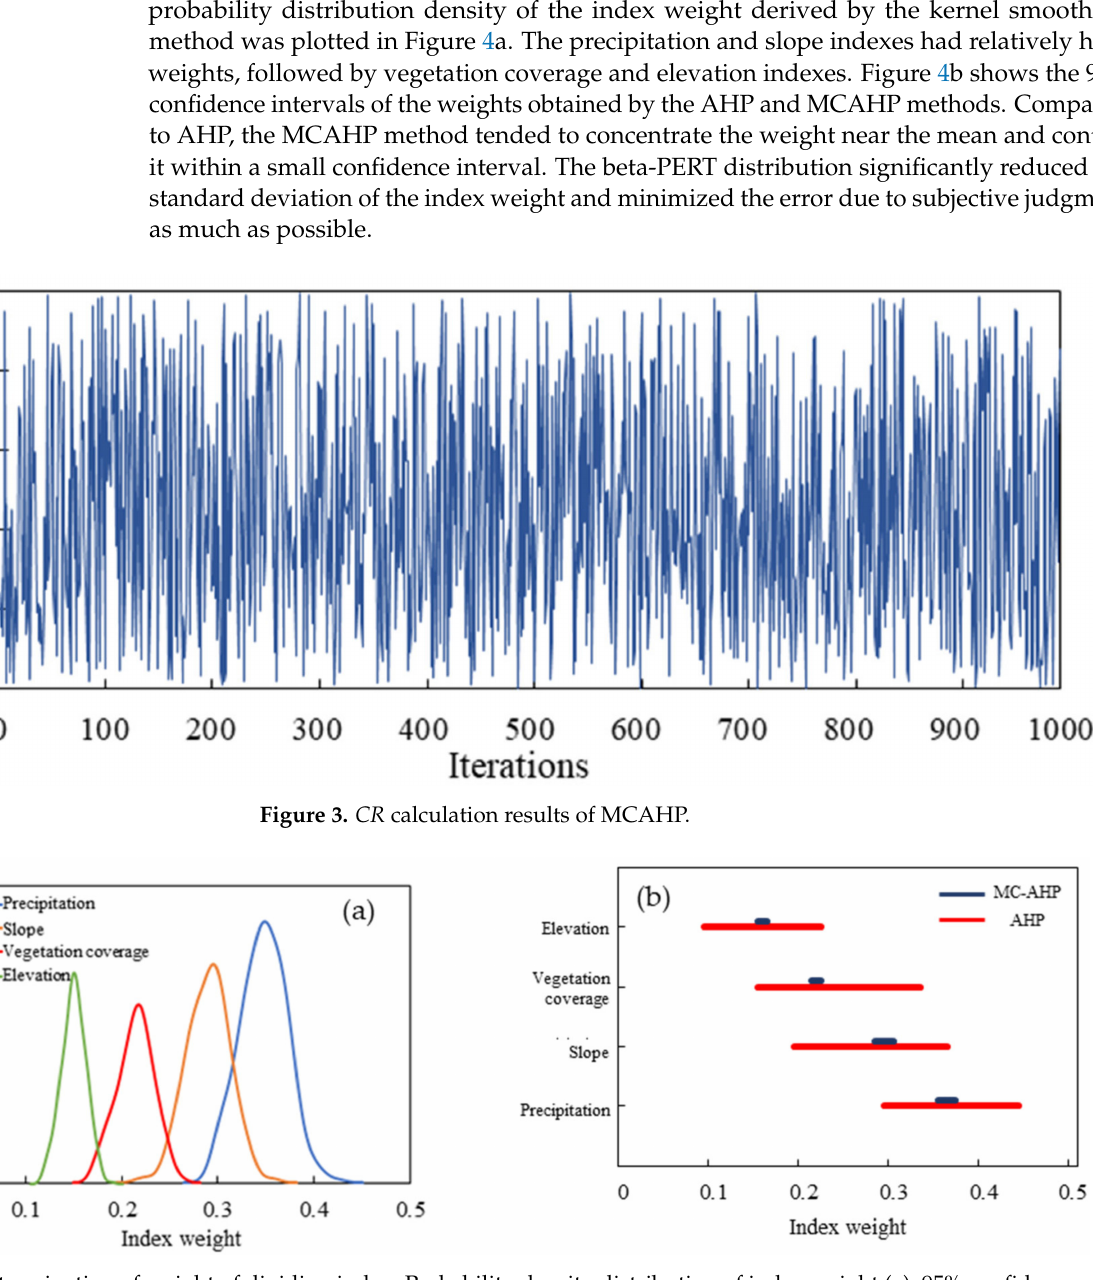
Figure 4. Determination of weight of dividing index: Probability density distribution of index weight ( a ), 95% confidence intervals for index weights ( b